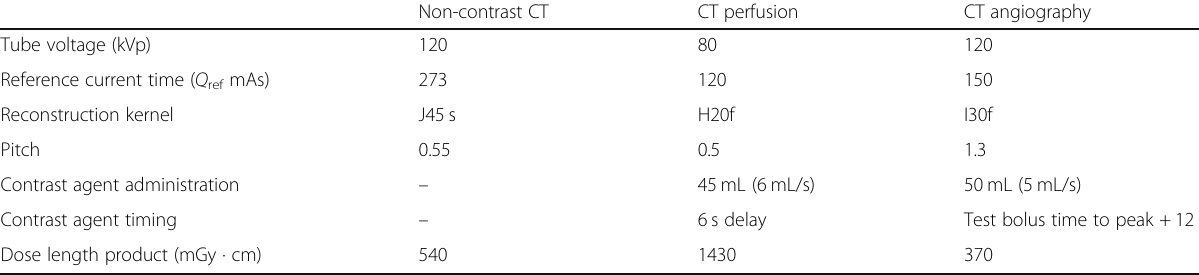
Table 1 Stroke scan protocol. Scout images and test bolus details are not reported Non-contrast CT CT